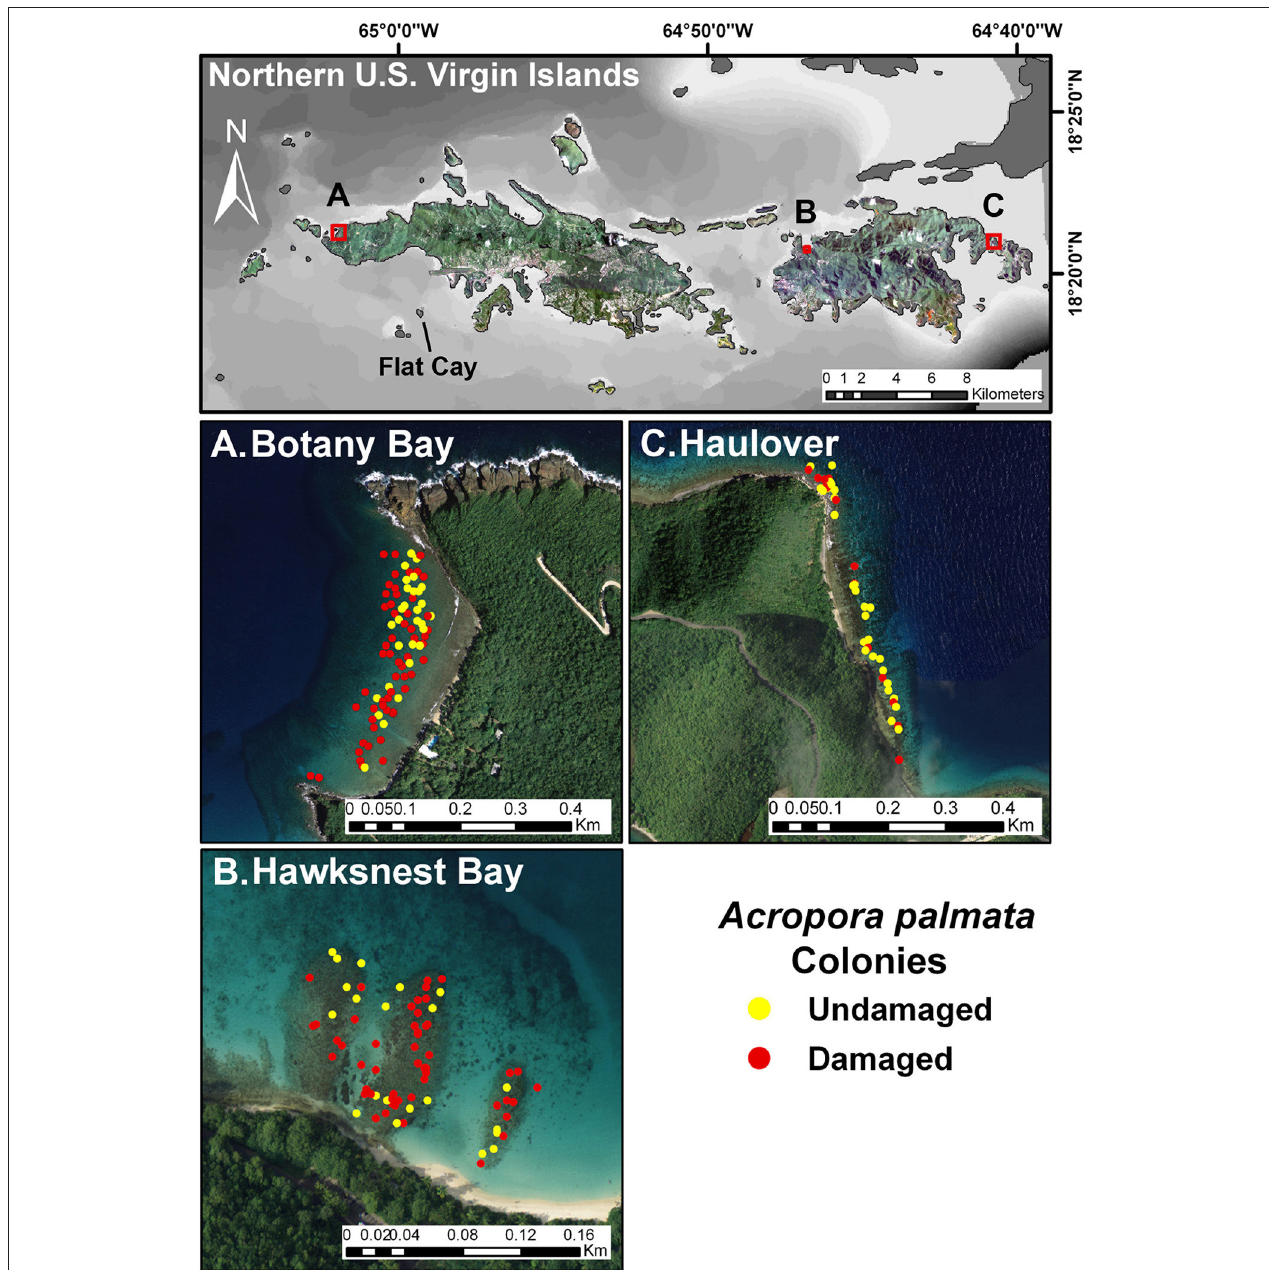
FIGURE 1 | Map of three main research sites on the north side of St. John and St. Thomas, US Virgin Islands. Close-up views show aerial imagery of the sampling sites with the positions of damaged and undamaged colonies of Acropora palmata indicated. The southern reference site, Flat Cay, is also indicated on the